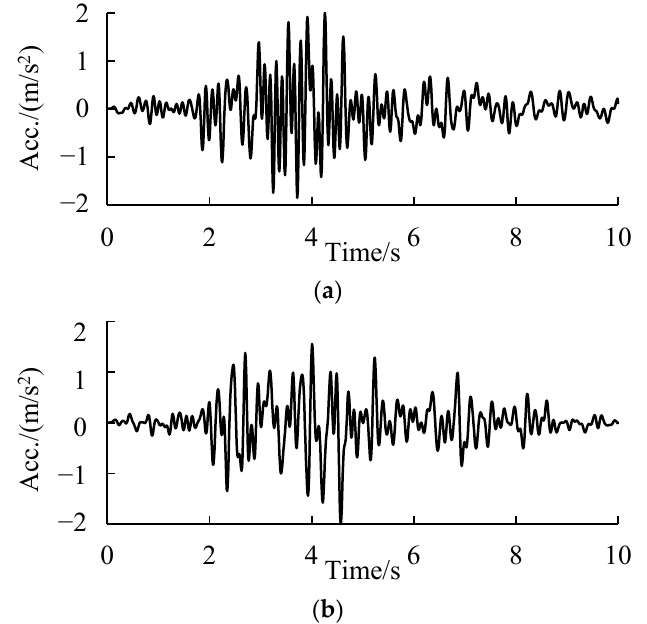
Figure 9. Acceleration time–history curve of the earthquake used in the numerical simulation. ( a ) Direction of perpendicular to the fault. ( b ) Direction of Parallel to the fault.